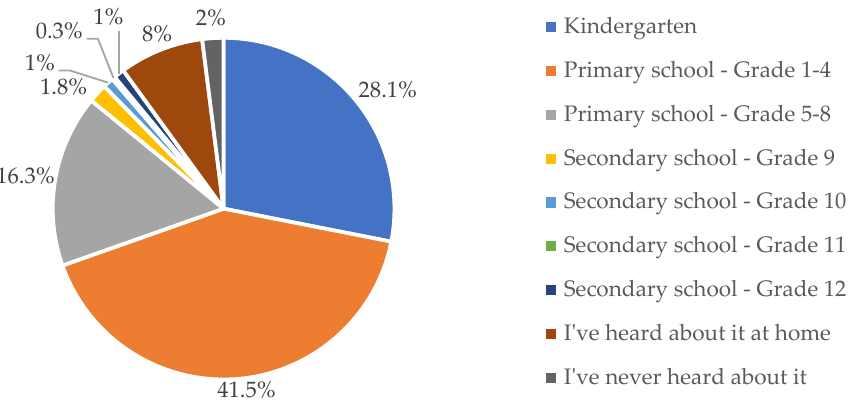
Figure 2. Distribution of students surveyed according to when they first learned about environmental education (%).